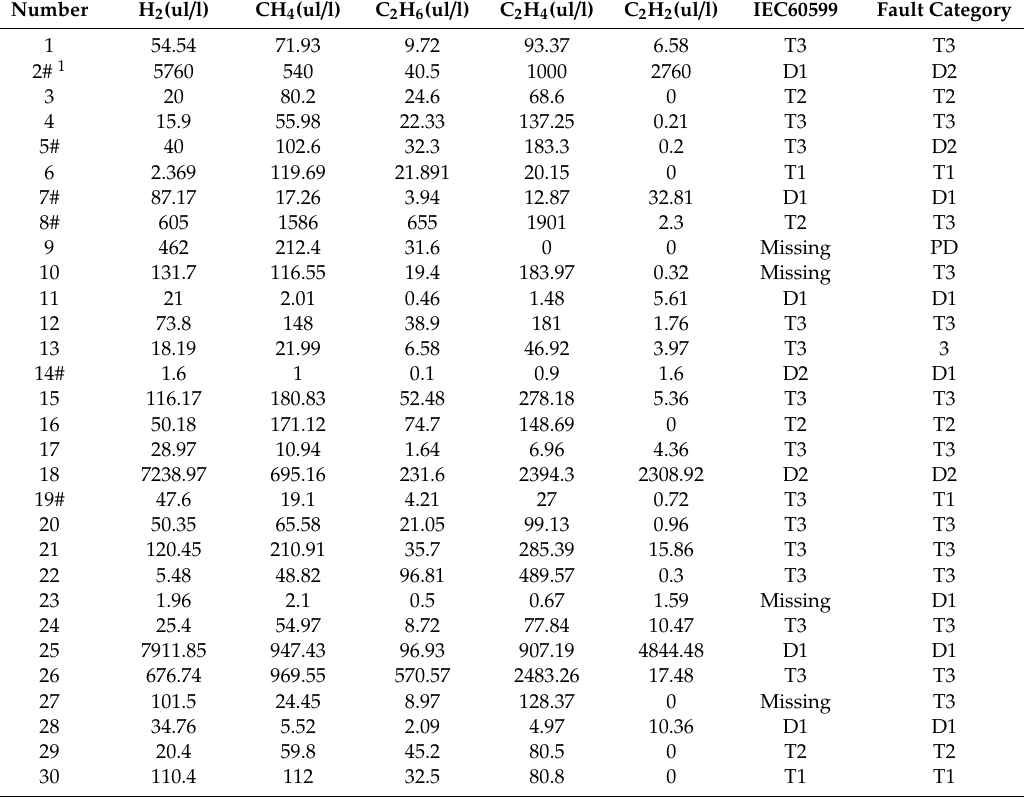
Table 5. DGA data fault type and IEC60599 diagnosis